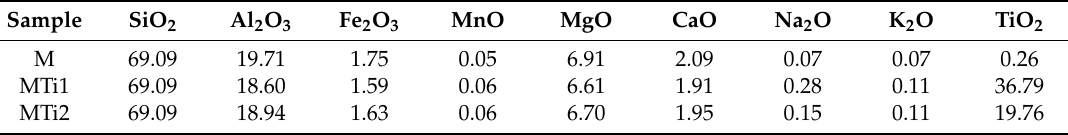
Table 2. Chemical composition of the samples, normalized to water–free composition and to the SiO 2 content in the starting montmorillonite (wt